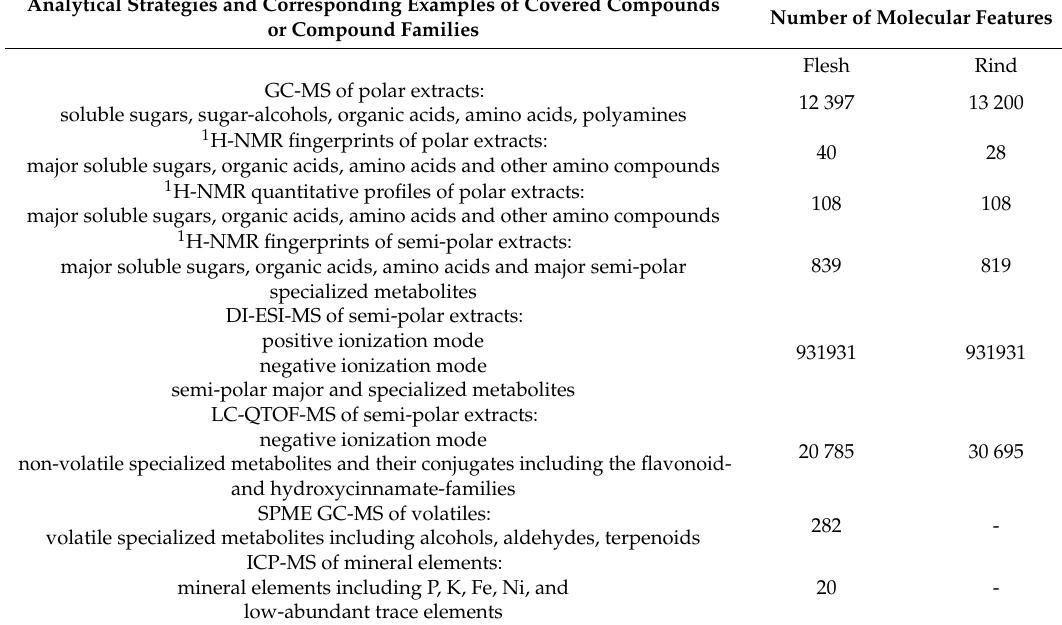
Table 2. Summary of the metabolome and elemental data measured using MS or NMR analytical strategies in extracts of fruit flesh or rind samples from of 52 melon